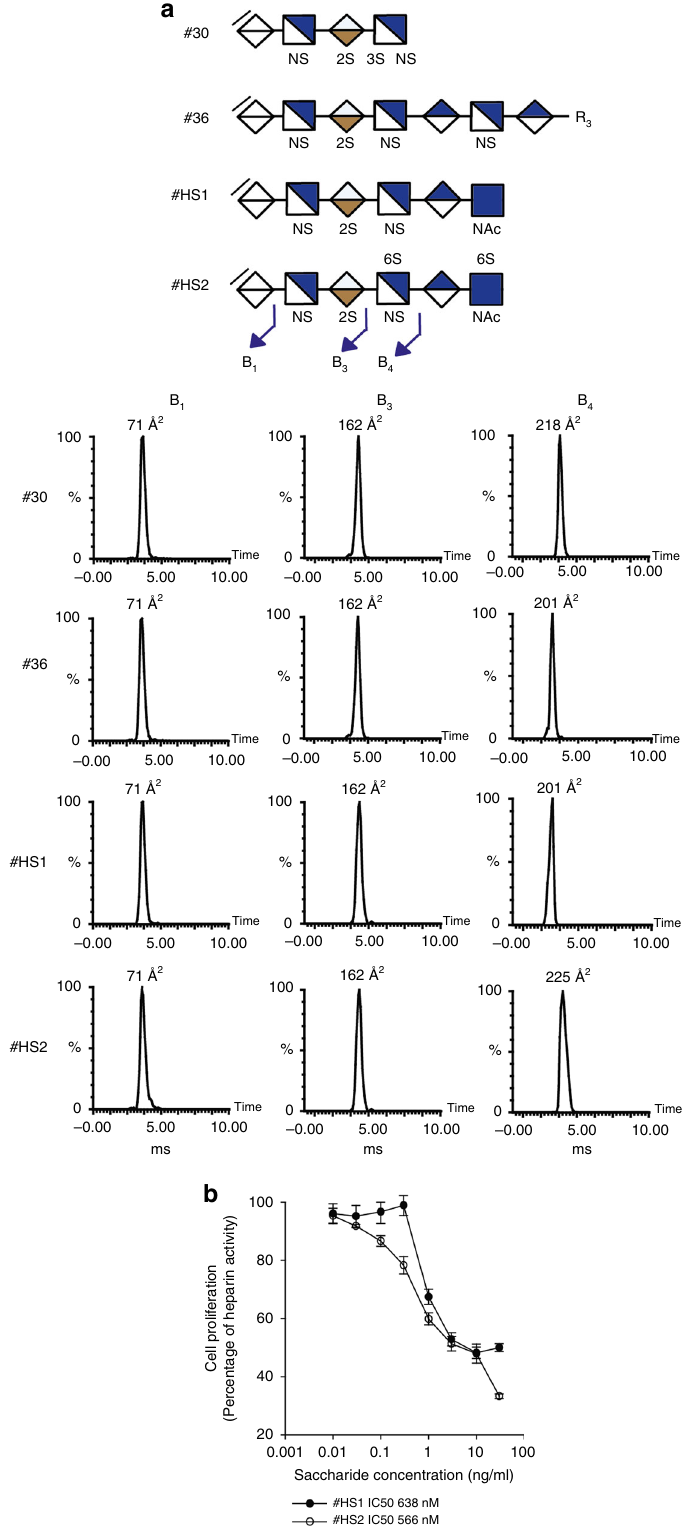
Fig. 5 Applying the SIMMS 2 method for sequencing HS motifs displaying FGF bioactivity. a SIMMS 2 sequencing of hexasaccharides #HS1 and #HS2 through the comparison of B ion fragment CCS values from standard #30 and #36 . b BaF3 FGF2 inhibition assay with a sub-maximal dose of heparin (0.1 μ g/mL) in the presence of serially diluted #HS1 (black circle with line) and #HS2 (white circle with line) saccharides. Data for ( b ) are presented as mean ± standard deviation, n = 3. Source data are provided as a Source Data fi